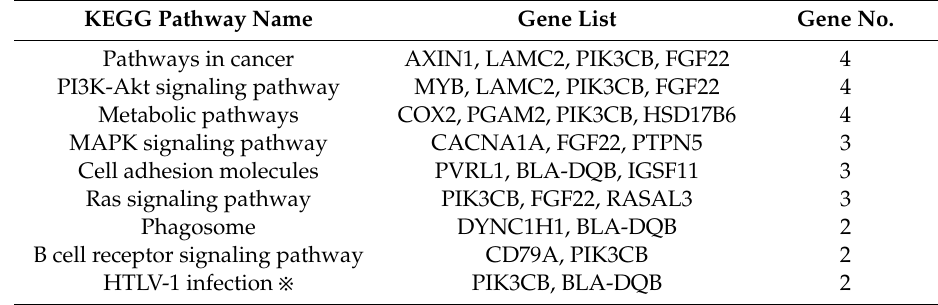
Table 2. Kyoto Encyclopedia of Genes and Genomes (KEGG) pathways (important 10) of DEGs (up-regulated and down-regulated) in milk EVs from BLV-infected cattle with HPL in Experiment 1.